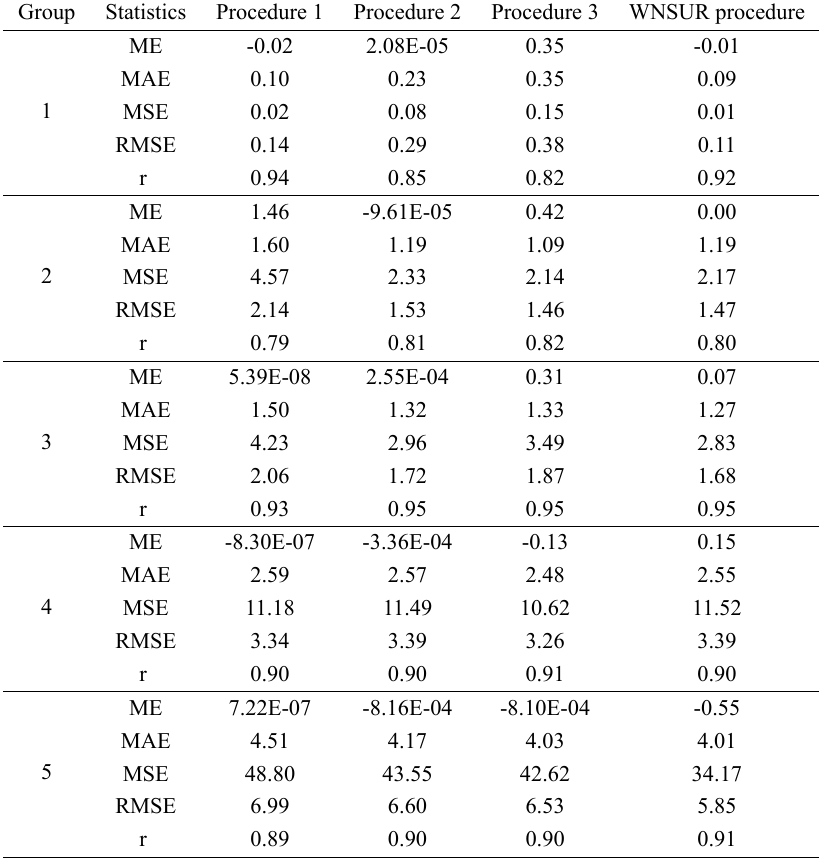
Statistics obtained for comparison the estimates trough ratio and WNSUR procedures of crown biomass in stands of black wattle in the state of Rio Grande do Sul,